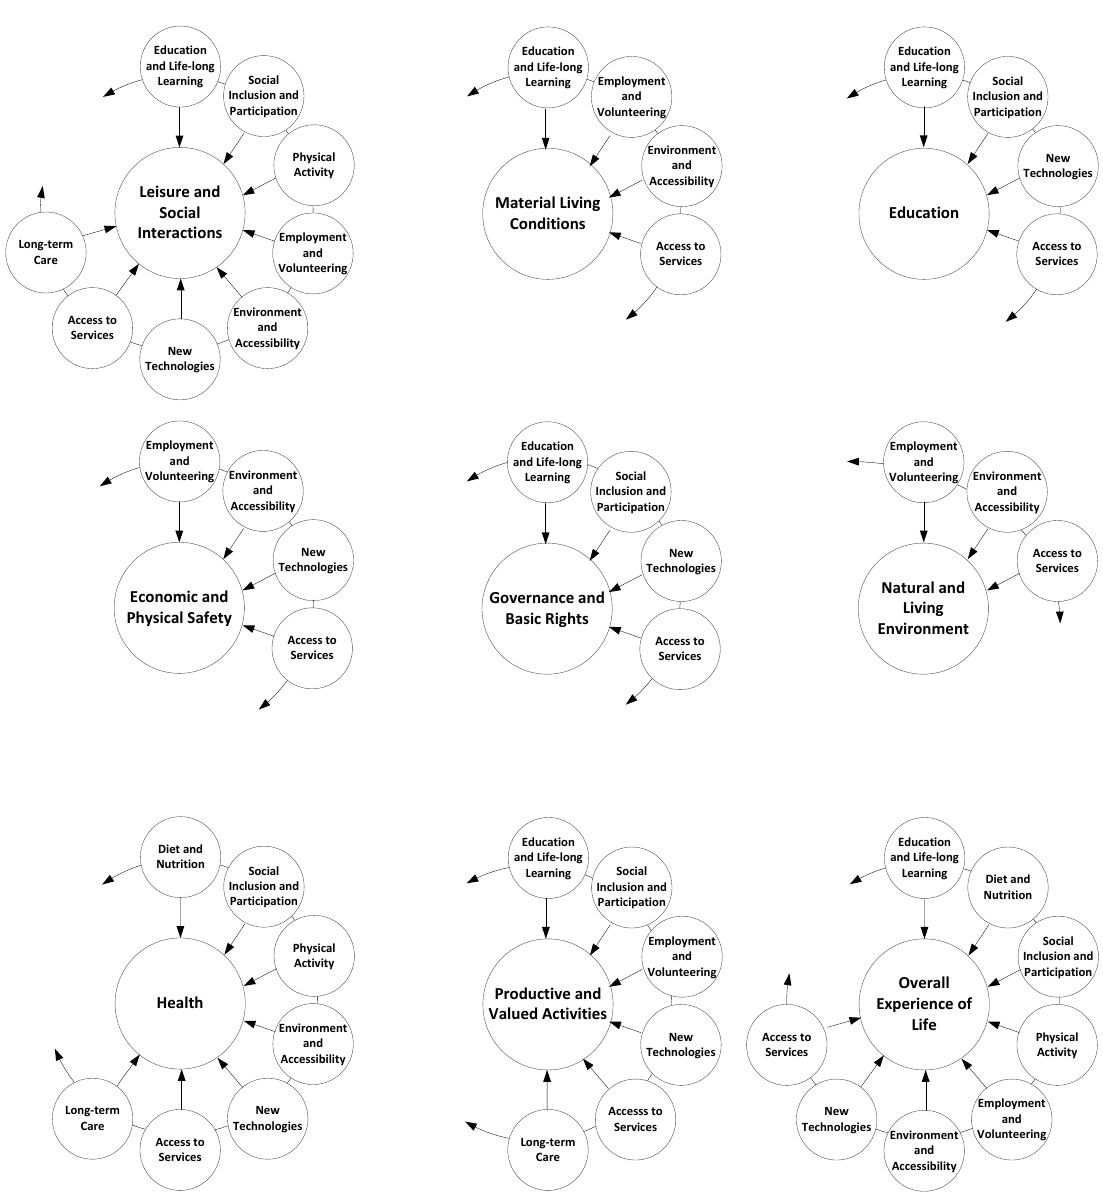
Figure 2. The proposed mapping of the smart determinants to QoL dimensions.